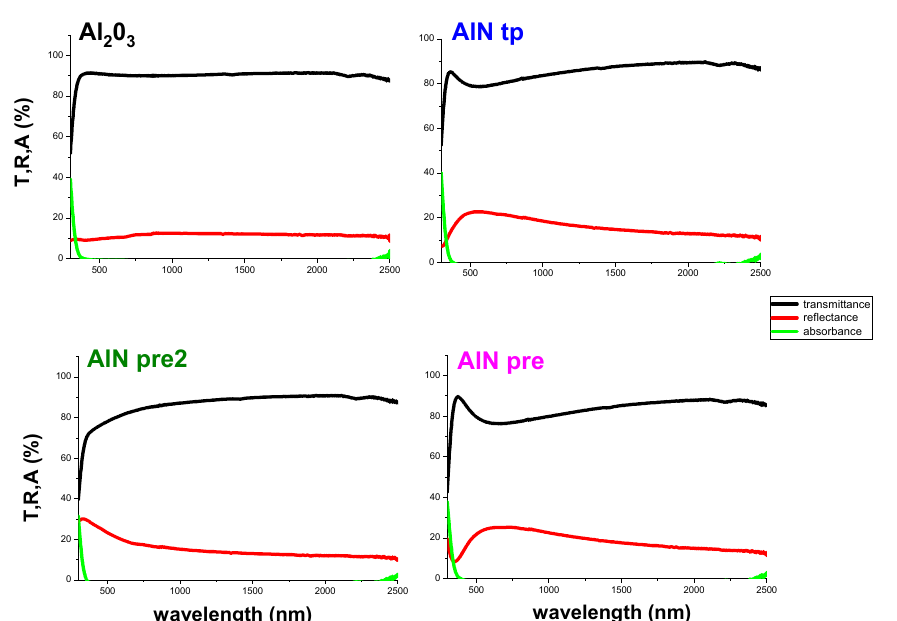
Figure 7. UV-Vis-NIR analysis of aluminum compounds thin films: Alumina, AlN tp , AlN pre2 , AlN pre .